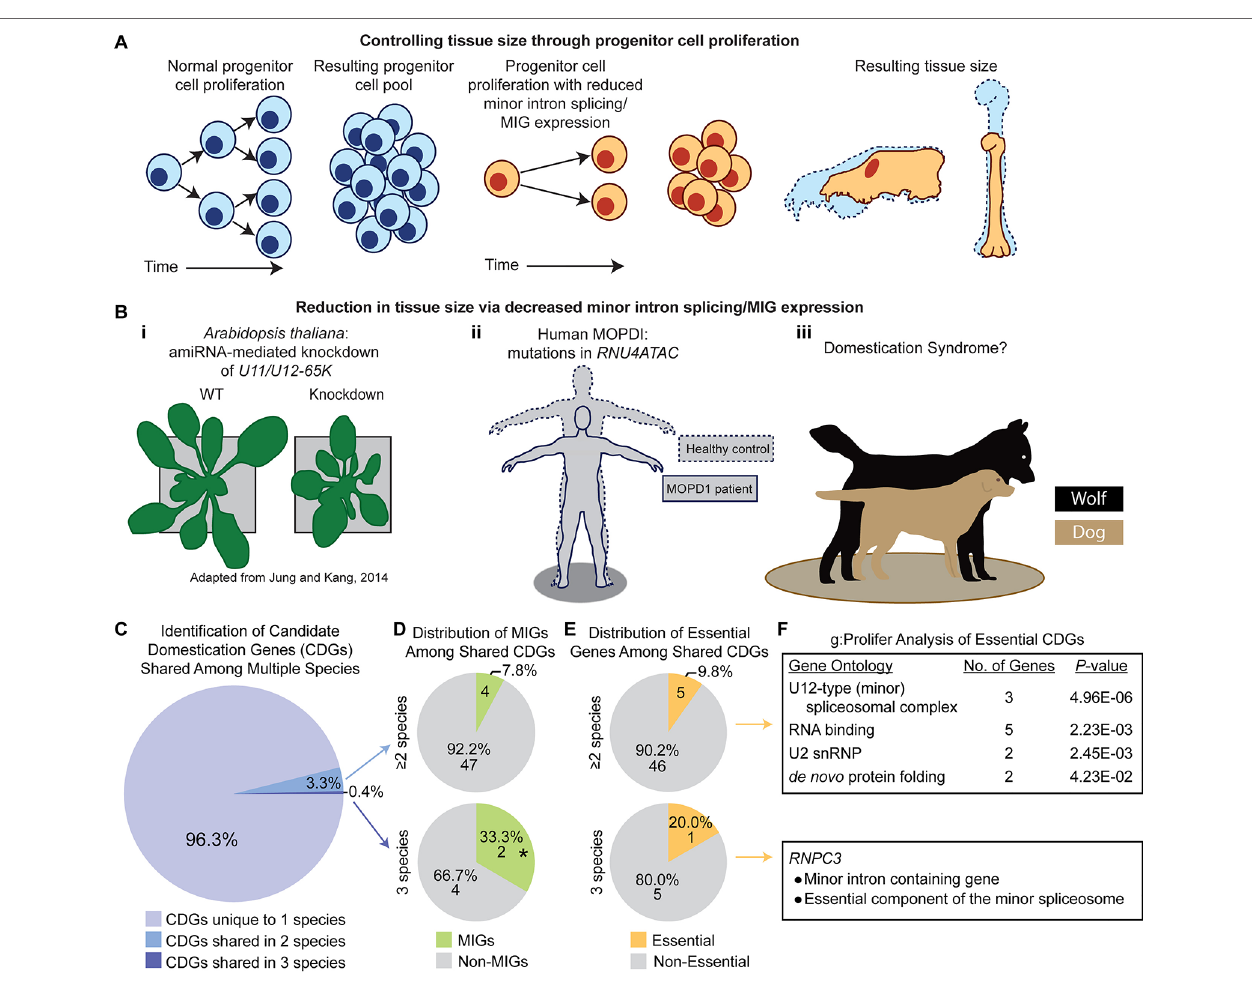
FIGUrE 6 | A potential role for the minor spliceosome in domestication. (A) A model demonstrating how tissue size can be controlled through progenitor cell proliferation. (B) Evidence for tissue size reduction upon impairment of minor intron splicing/minor intron-containing gene (MIG) expression. i ) Plant size is smaller in A. thaliana upon knockdown of the minor spliceosome-specific U11/U12-65K . Reproduced with permission from Jung and Kang, 2014. ii ) Mutations in RNU4ATAC cause three diseases in human, such as microcephalic osteodysplastic primordial dwarfism type 1 (MOPD1), wherein patients’ display reductions in multiple tissues causing a severely reduced body plan relative to healthy controls (theoretical output). iii ) Previous studies suggest a link between reduced minor intron splicing/MIG expression and domestication syndrome, of which one prominent example is the domestication of dog (beige) from wolf (black). (C) Pie-chart representing the distribution of candidate domestication genes (CDGs) from dog, cat, cattle, horse, and anatomically modern human curated from Theofanopoulou et al. (2017) that are unique to one species (light purple), overlap in two species (blue), or are shared among three species (dark purple). (d) Pie-chart showing the number of MIGs (green) or non-MIGs (gray) found within the list of CDGs shared between two (top) or three (bottom) species. (E) Pie-chart showing the number of essential (yellow) or non-essential (gray) genes found within the list of CDGs shared between two (top) or three (bottom) species. (F) Description of gene enrichment (as determined through g:Profiler) for essential genes shared among two or three species (only one gene, RNPC3 , is both essential and a shared CDG among three species). Significance determined by Fisher’s exact test; * P <